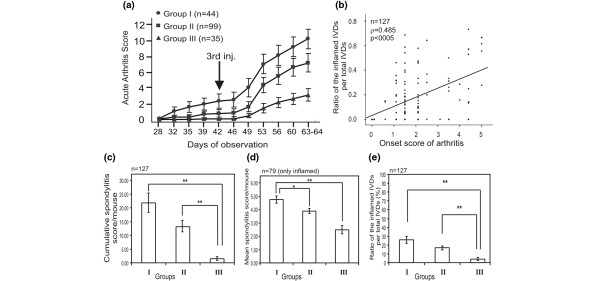
Progression and severity of arthritis in 11 BALB/c colonies sorted into three different groups (listed in Table 1), correlation between the onset of arthritis and spine involvement, and comparison of the three arthritic groups with different spine inflammation scores. (a) Each animal was scored for arthritis three times a week, and scores are shown as mean ± standard error of the mean. Arrow indicates the third injection, administrated on day 42. Significant differences (P < 0.01), calculated by one-way analysis of variance, were found from day 32 between groups I, II, and III. (b) The ratio of the number of inflamed intervertebral discs (IVDs) per the total number of IVDs showed positive significant correlation (Pearson correlation coefficient ρ = 0.485; P < 0.0005) with the onset of arthritis. (c-e) Significant differences were found among the three arthritic groups when compared with three spine representative scores: cumulative spondylitis score (c), the mean spondylitis score (d), and the ratio of the number of inflamed IVDs per total number of IVDs (e). Asterisks indicate the level of significance between groups (*P < 0.05 and **P < 0.01) using Tamhane (c, e) (n = 127) and least significant difference (d) (n = 79) post hoc tests.